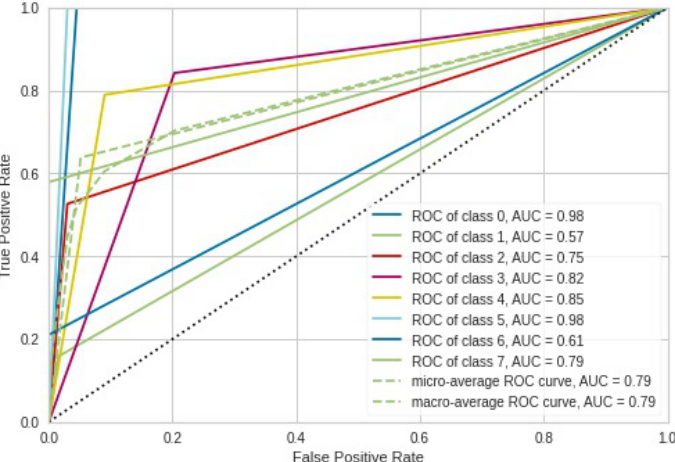
Figure 18. ROC AUC Curves for Gaussian-naive-Bayes-based